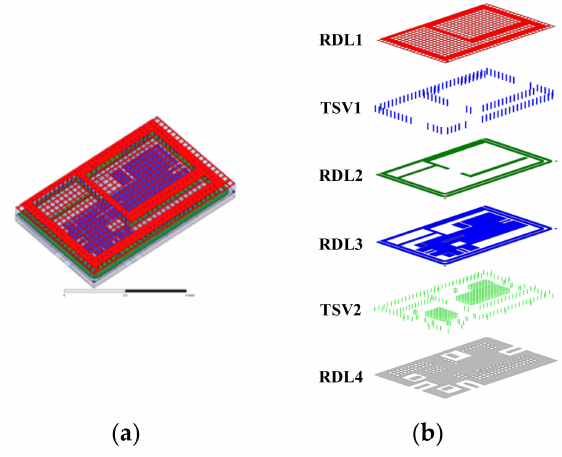
Figure 12. 3D layout rendering of the receiving channel 2 of the double stacked RF module.